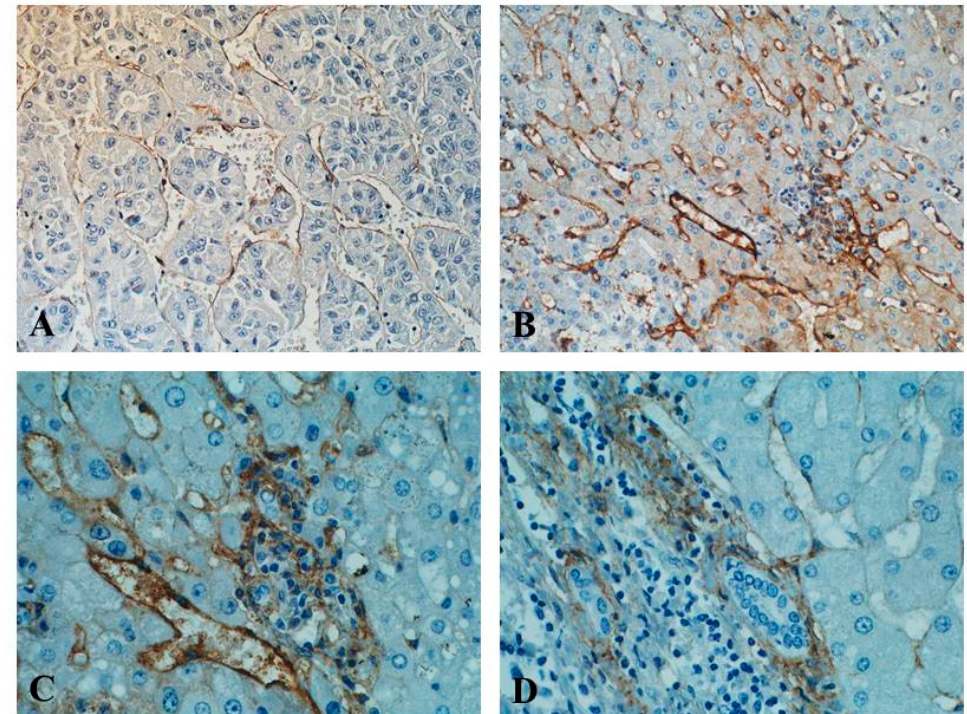
Figure 1. Immunohistochemical expression of endoglin (CD105) as shown by brown staining of the vasculature in HCC samples. ( A ) CD105 immunoexpression in tumour sinusoidal endothelial cells; ( B ) CD105 immunoexpression in tumour microvessels of other patient with HCC (hot spot area); ( C ) higher magnification of the HCC fragment of the same patient, showing ECs and CD105-immunopositive inflammatory cells; ( D ) very weak CD105 localization in peritumoral hepatic tissue and in bile duct cells in portal space. New polymer-based immunohistochemistry with DAB staining. Haematoxylin counterstained. Original magnification × 200 ( A , B ); × 400 ( C , D ) (our unpublished